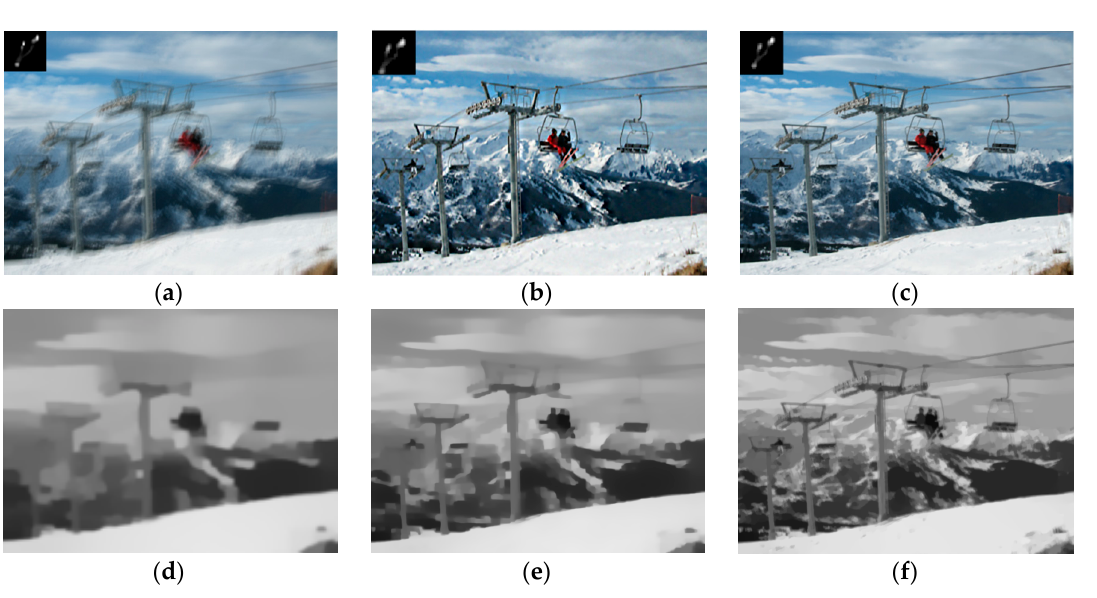
Figure 5. Results comparison of [7] and our method. ( a ) Blurred image and truth kernel; ( b ) result of [7]; ( c ) result of our method; and ( d – f ) interim S maps with our method. Our result shown in ( c ) is better.